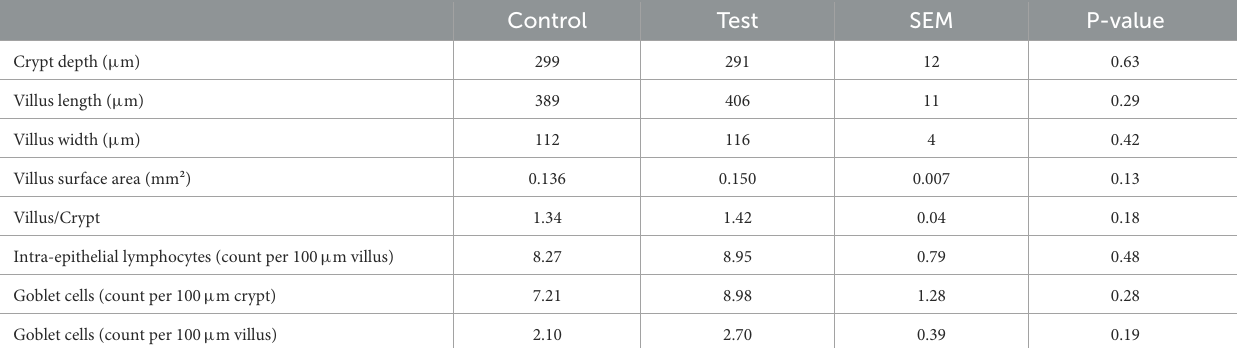
TABLE 5 Histo-morphological indices of the small intestine (section at 75% of small intestine length) of piglets at d14 post-weaning, when fed a control diet (Control; n = 10) or a diet containing 2 kg/ton specific fiber fractions derived from Araceae root and citrus (Test; n = 10) from d0 to d14 post-weaning.